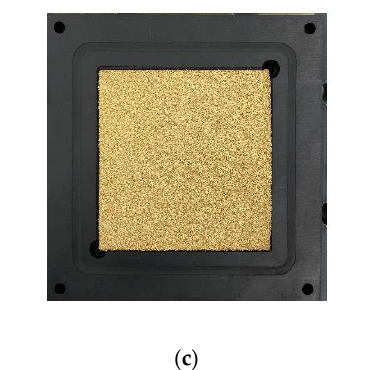
Figure 2. ( a ) A 25 cm 2 polymer electrolyte fuel cell (PEFC) single cell. ( b ) Four-channel serpentine flow field. ( c ) Metal foam flow field.